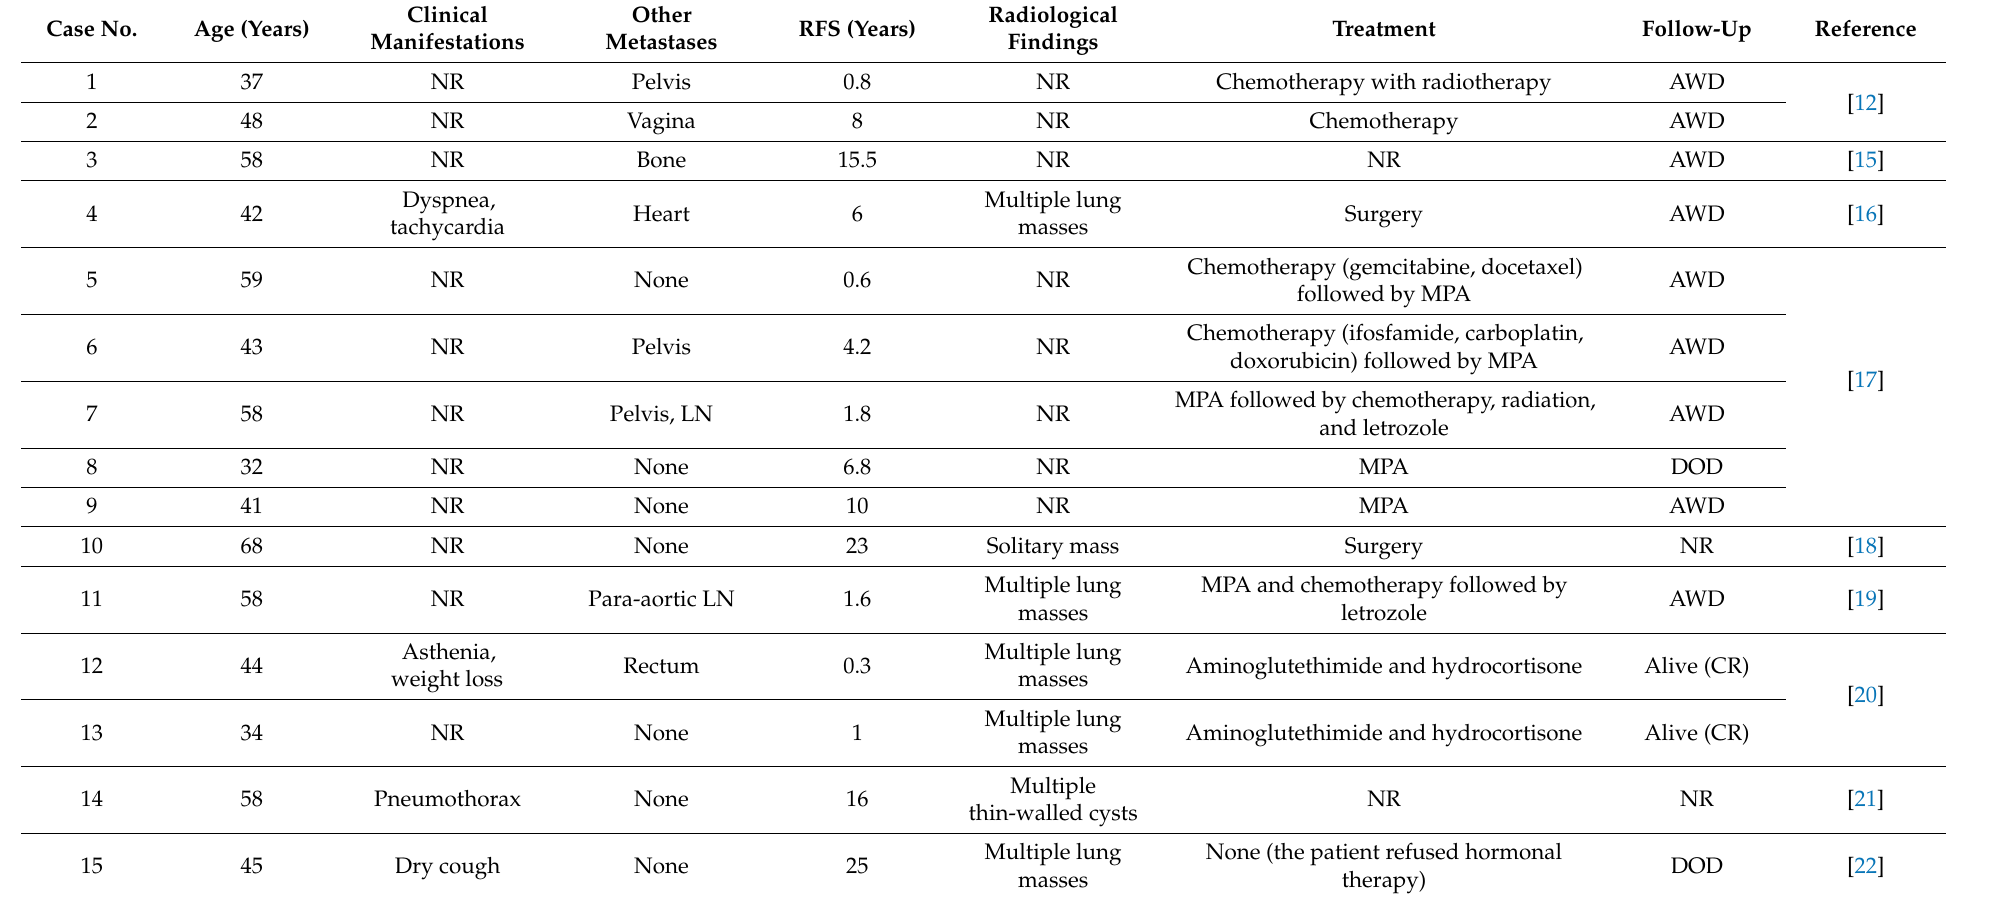
Table 1. Summary of published literature reporting pulmonary metastasis from